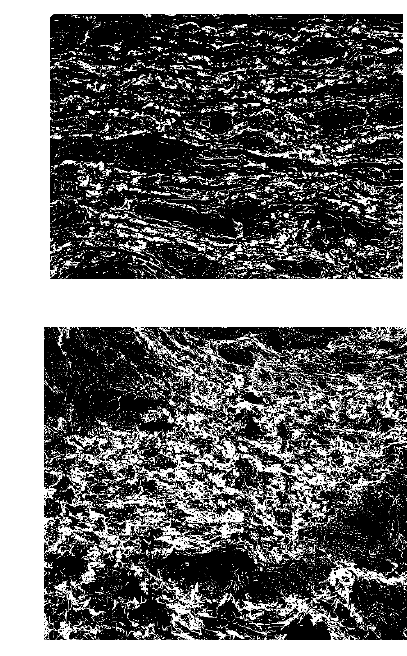
Figure 21. Segmentation before ( A ) and after ( B ) treatment (orcein).